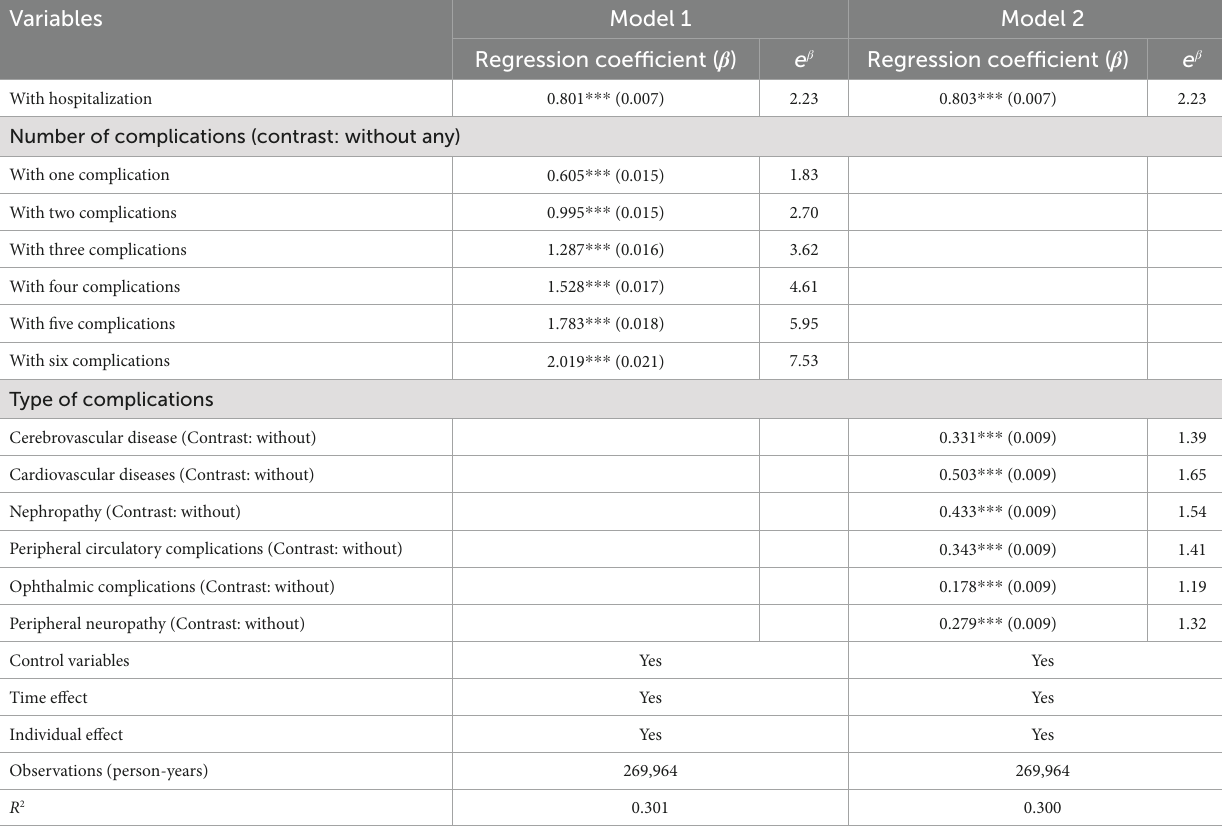
TABLE 3 Factors influencing of diabetes-related costs for patients with